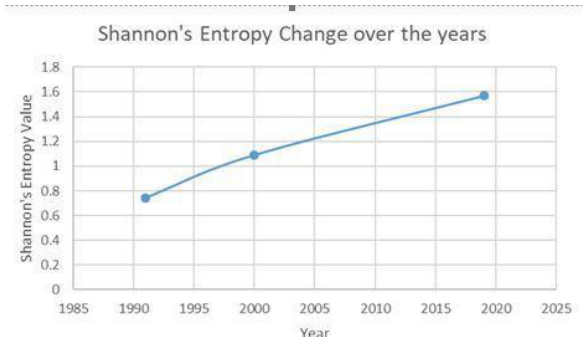
Figure 7 : Graphical Variation of Shannon’s Entropy Values Over the